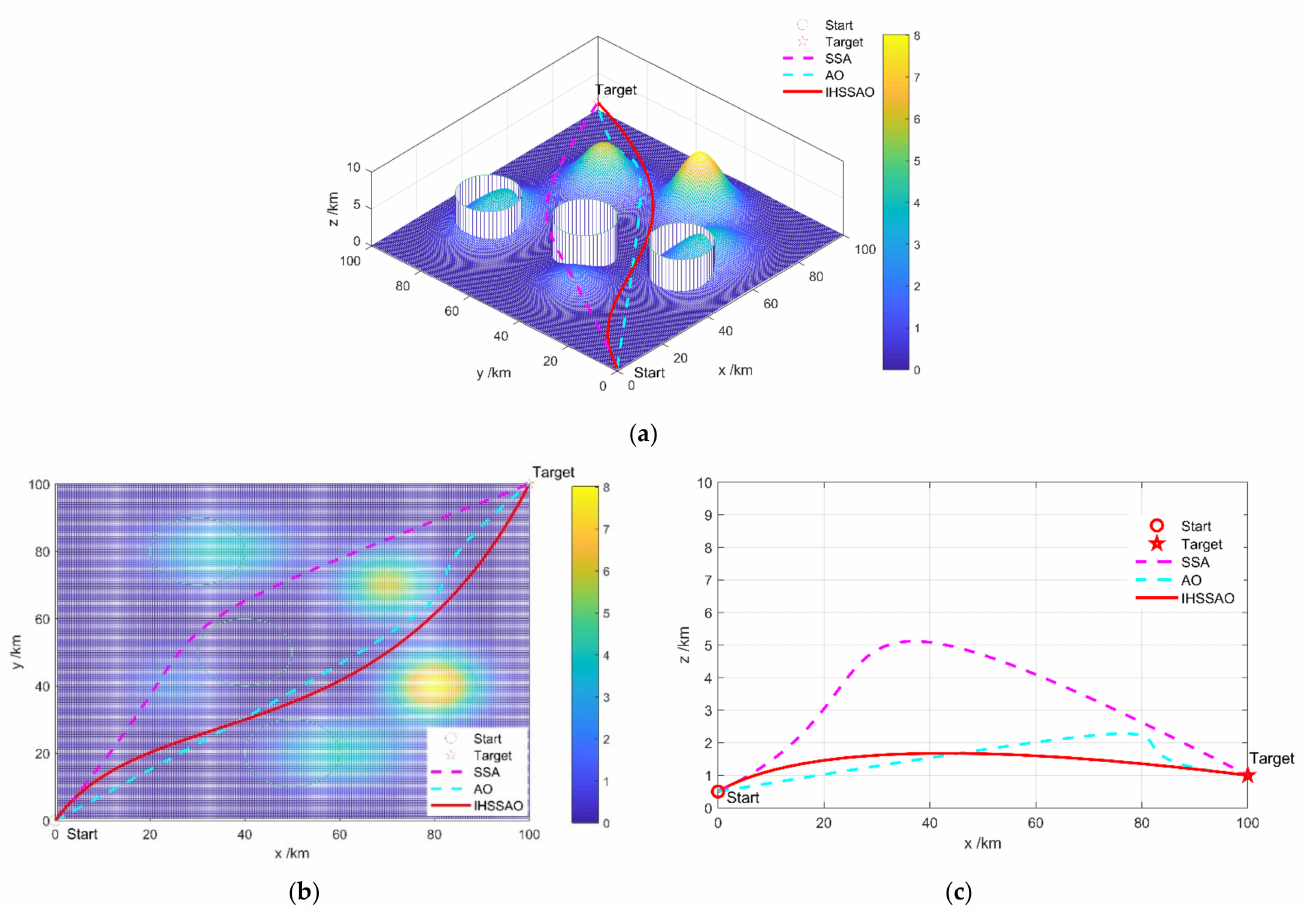
Figure 10. The best path of SSA, AO, and IHSSAO. ( a ) Path comparison in three-dimensional space.